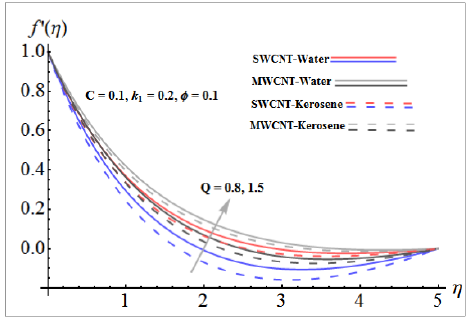
Figure 2. Behavior of f ′ ( η ) for increased values of Q .